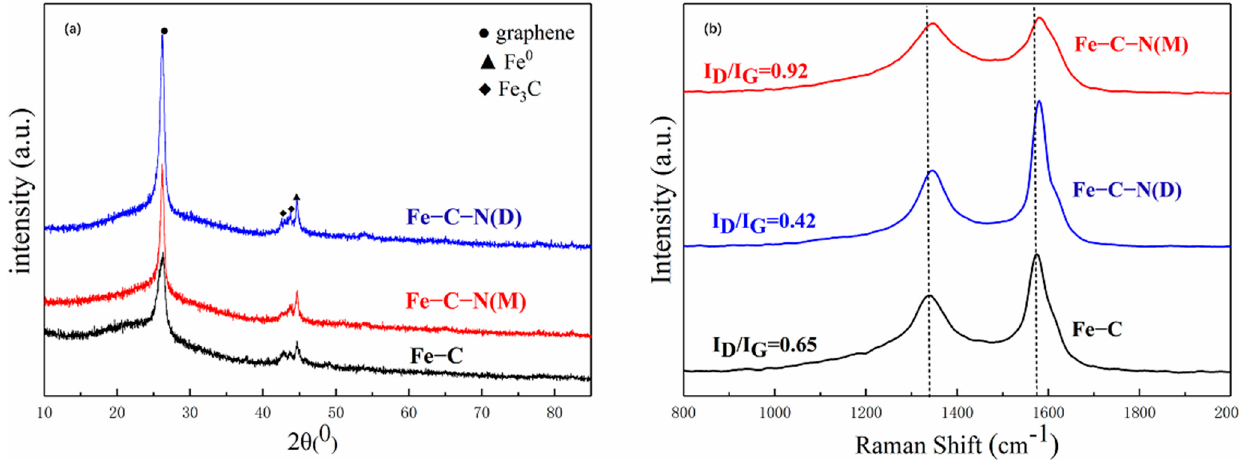
Figure 3. ( a ) XRD patterns ( b ) Raman spectra image of Fe-C, Fe-C-N(D), and Fe-C-N(M).